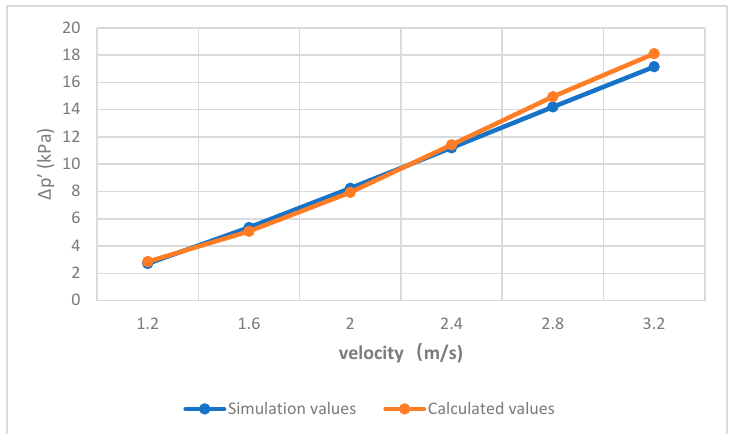
Figure 3. Comparison of pressure drop.